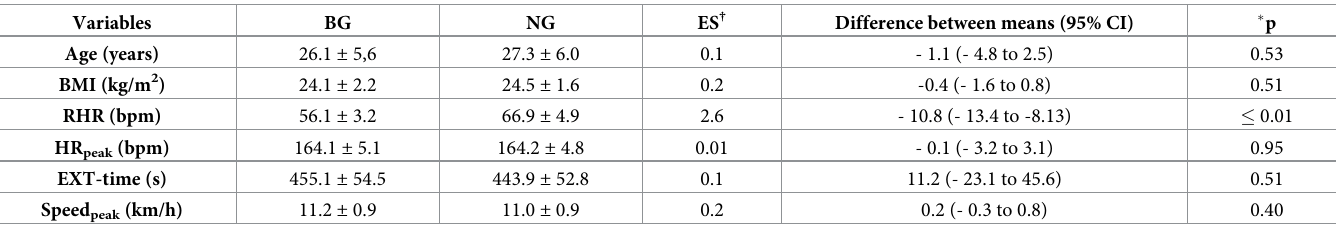
Table 1. Comparative values of age, body mass index, resting heart rate, heart rate peak, and total effort time in the BG (n = 20) and NG (n = 20). Variables BG NG ES † Difference between means (95% CI) � p Age (years) 26.1 ± 5,6 27.3 ± 6.0 0.53 BMI (kg/m 2 ) 24.1 ± 2.2 24.5 ± 1.6 RHR (bpm) 164.1 ± 5.1 EXT-time (s) 455.1 ± 54.5 443.9 ± 52.8 Speed peak (km/h) 11.2 ±